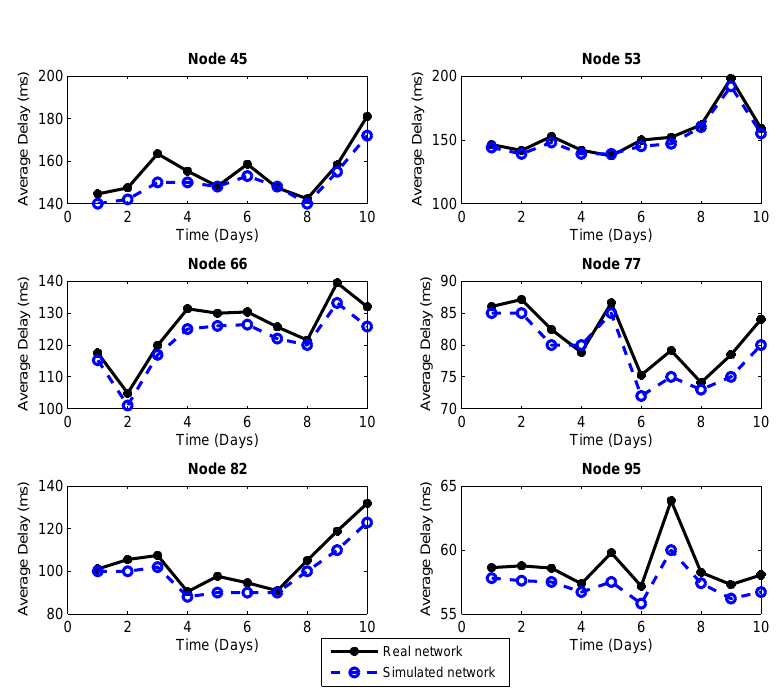
Figure 5. Average delay per day in relay